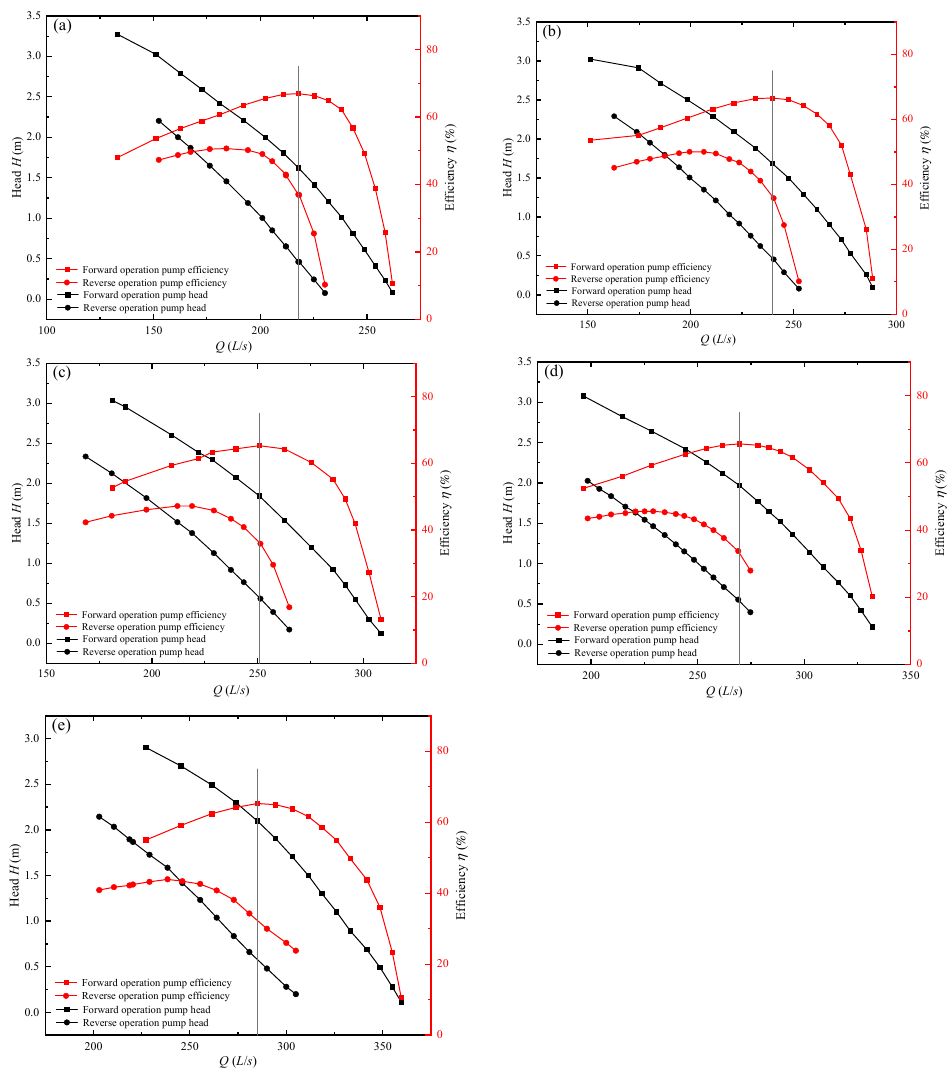
Figure 5. Energy characteristics of the pump for blade angle β = ( a ) − 4°; ( b ) − 2°; ( c ) 0°; ( d ) +2°; ( e ) +4°. Vertical line stands for Q = Q d